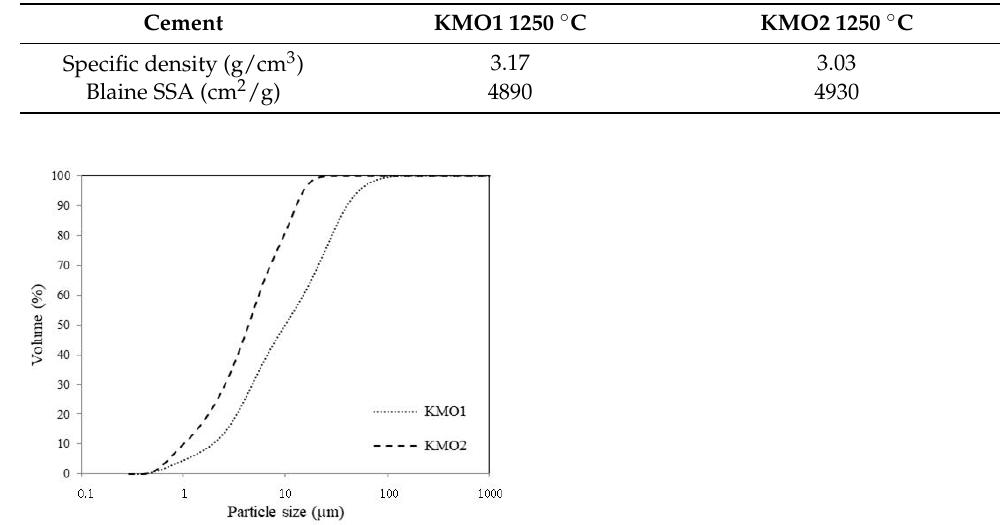
Figure 1. Particle size distribution (PSD) of cements from raw mixtures KMO1 and KMO2 sintered at 1250°C, as determined by laser diffraction (Microtrac SYNC Model 5001, Microtrac Retsch GmbH, Haan, Germany; dry operation).